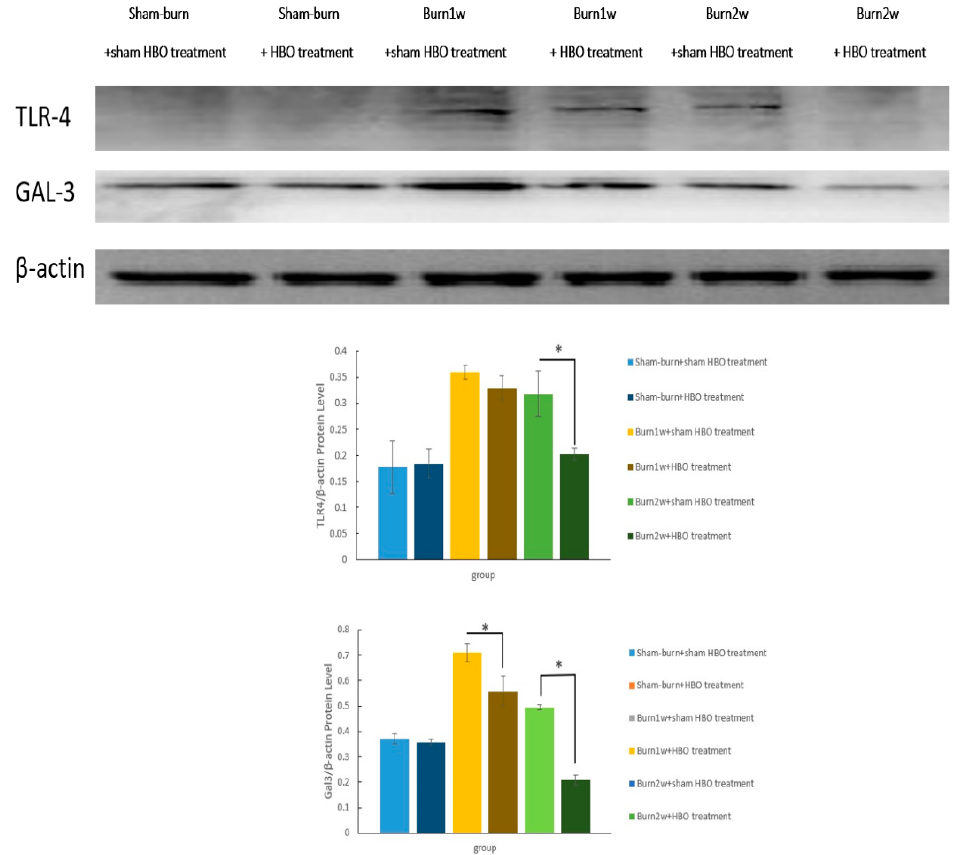
Figure 5. HBO treatment inhibited the expression of the inflammatory proteins GAL-3 and TLR-4 in the spinal cord dorsal horn. Western blot analyses of TLR-4 and GAL-3 in the spinal cord dorsal horn at one and two weeks after burn injury. β -actin was used as an internal control. Protein expression of GAL-3 decreased significantly in the burn with HBO treatment group compared with the burn with sham HBO treatment group (* p < 0.05), and protein expression of TLR-4 decreased significantly in the burn with two-week HBO treatment group compared with the burn with two-week sham HBO treatment group (* p < 0.05).